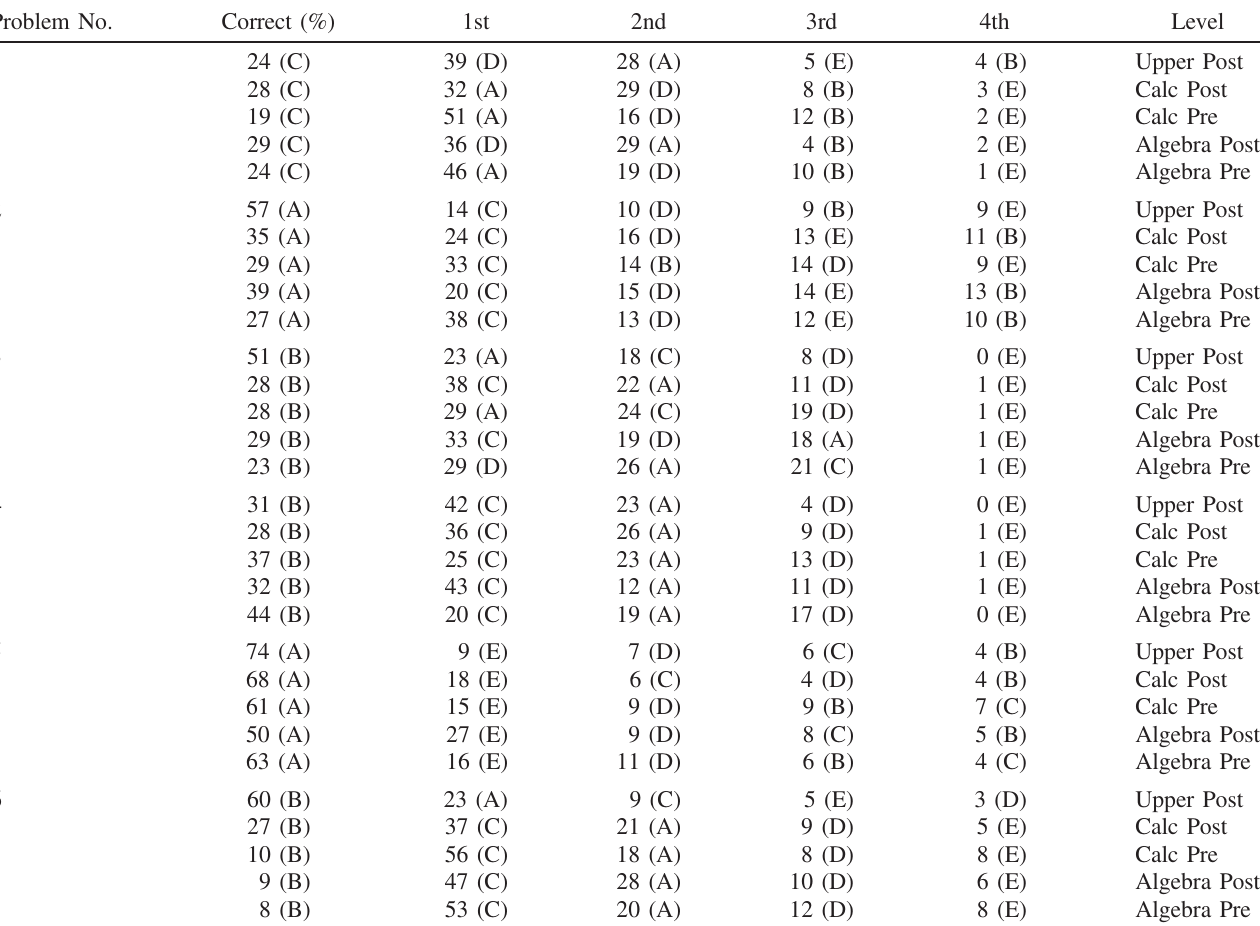
TABLE IV. Average percentage scores for each of the five choices for each item on the STPFaSL instrument for each group. Pre or pretest refers to the data before instruction in a particular course in which the survey topics in thermodynamics were covered (as discussed in the text, students in a course may have learned these topics in other courses). Post or post-test refers to data after instruction in relevant concepts in that particular course. Abbreviations for various student groups: Upper (students in junior or senior level thermodynamics and physics Ph.D. students in their first semester of a Ph.D. program who had also only taken the junior or senior level thermodynamics course), Calc (students in introductory calculus-based physics courses), Algebra (students in introductory algebra- based physics courses). The first column shows the percentage of students who answer the item correctly, and the corresponding answer choice. The four remaining columns list the percentages of incorrect answers (and choices), ranked by frequency. The number of students in each group is the same as in Table III except upper-level post and Ph.D. students Ind. are combined into Upper Post. Problem